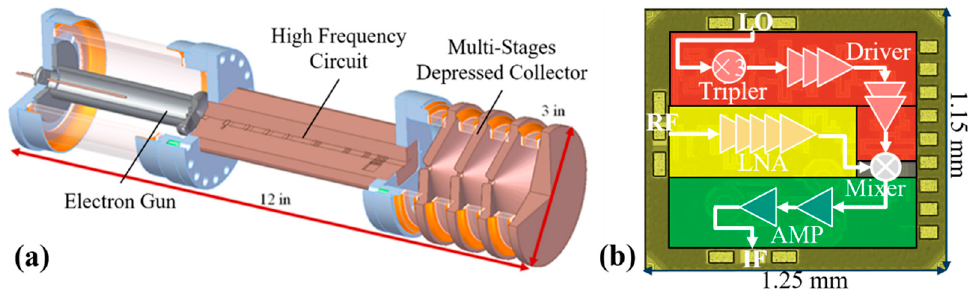
Figure 15. General view of the ( a ) W-band LUWK and ( b ) F-band SoC Chip.